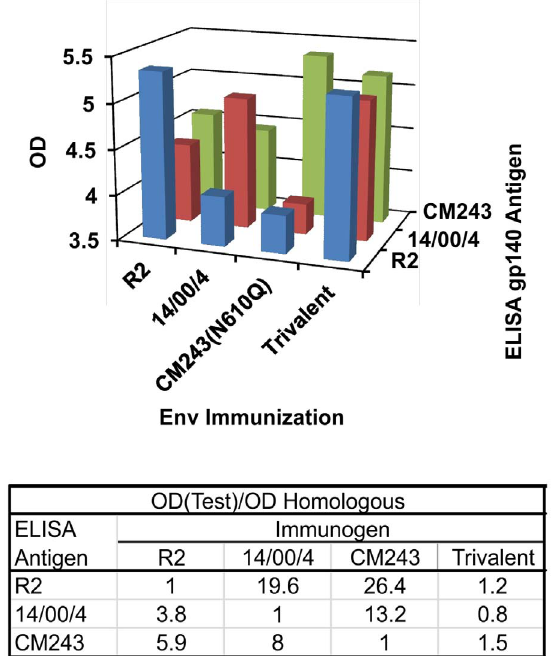
Figure 4. Immunoglobulin G responses of monkeys measured by enzyme linked immunosorbent assay using gp140 antigens of strains R2, 14/00/4, and CM243. A. Geometric mean titers are shown for the 6 monkeys in each of the immunization groups against each of the gp140 antigens. B. Ratios of GMT of sera of monkeys in group receiving the same antigen as the test/GMT of sera from monkeys receiving the heterologous antigens. Sera were substantially more reactive with homologous than heterologous antigens, and trivalent immunization resulted in responses against each antigen similar to homologous monovalent